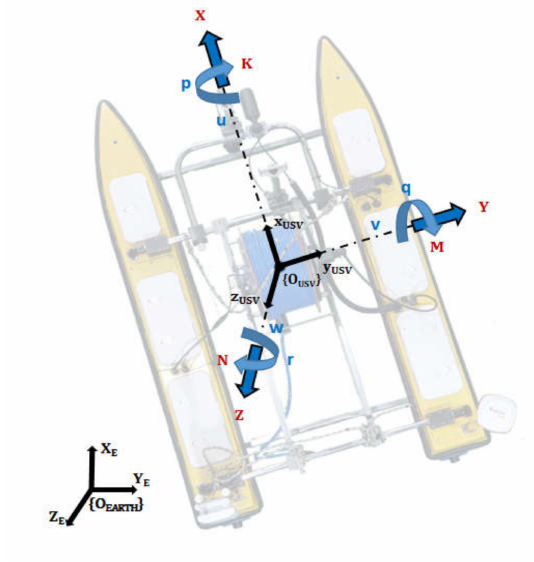
Figure 8. Earth-fixed and body-fixed coordinate